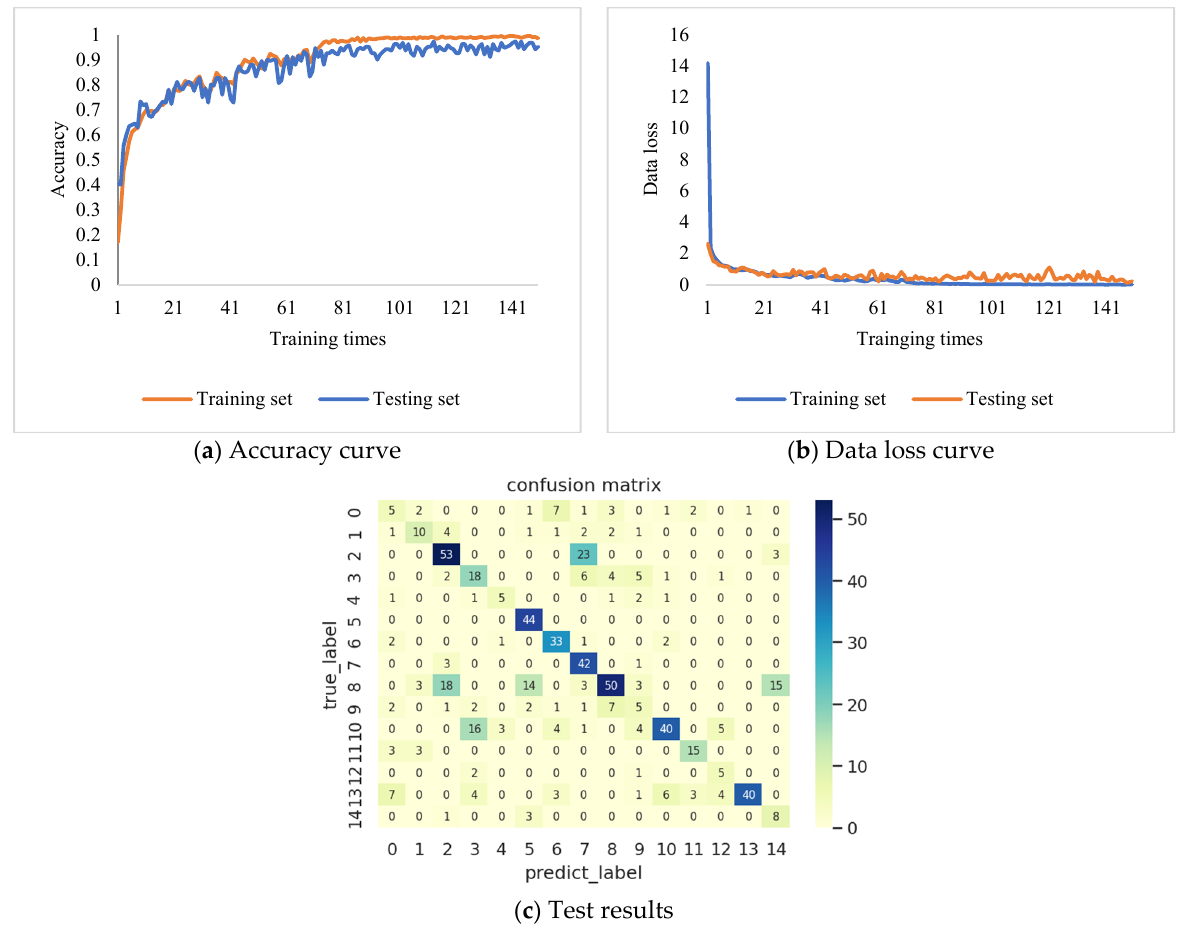
Figure 15. Training results of the transfer learning model based on the Xception model.